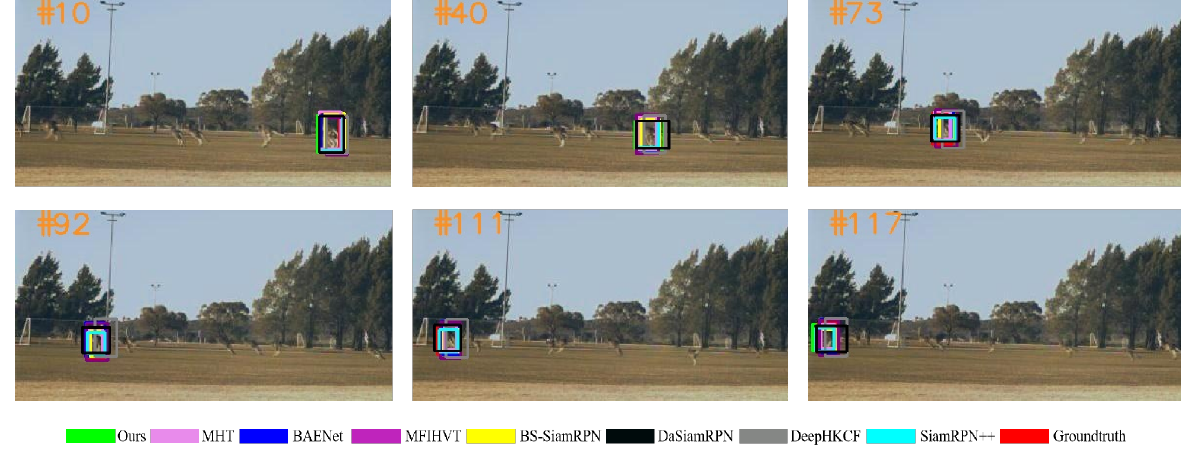
Figure 12. Qualitative results on the kangaroo sequence.